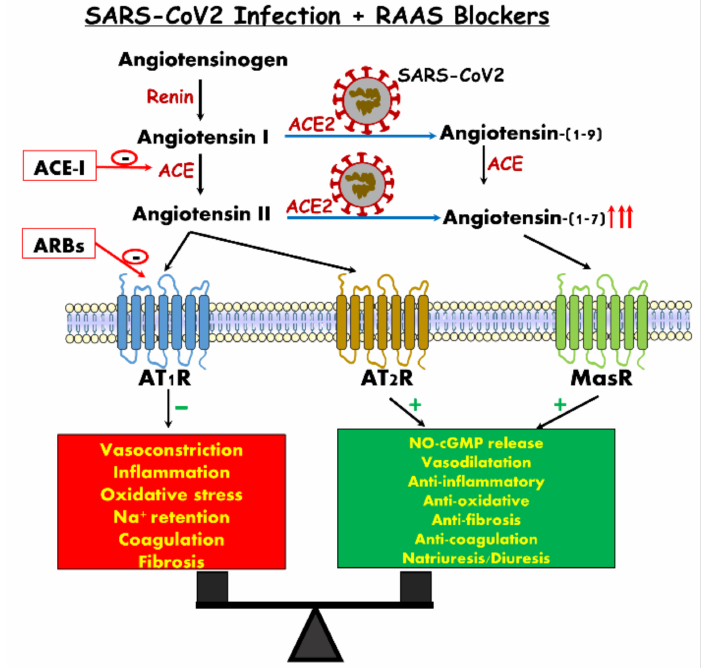
Figure 2. Concomitant renin–angiotensin system (RAS) inhibition with angiotensin converting enzyme (ACE) inhibitors or angiotensin II receptor blockers (ARBs) may restore the balance, with parallel suppression of signals mediated by angiotensin II receptor type 1 (AT1R) along augmentation of the angiotensin converting enzyme 2/ angiotensin 1-7/Mas Receptore (ACE2/Ang 1-7/MasR)